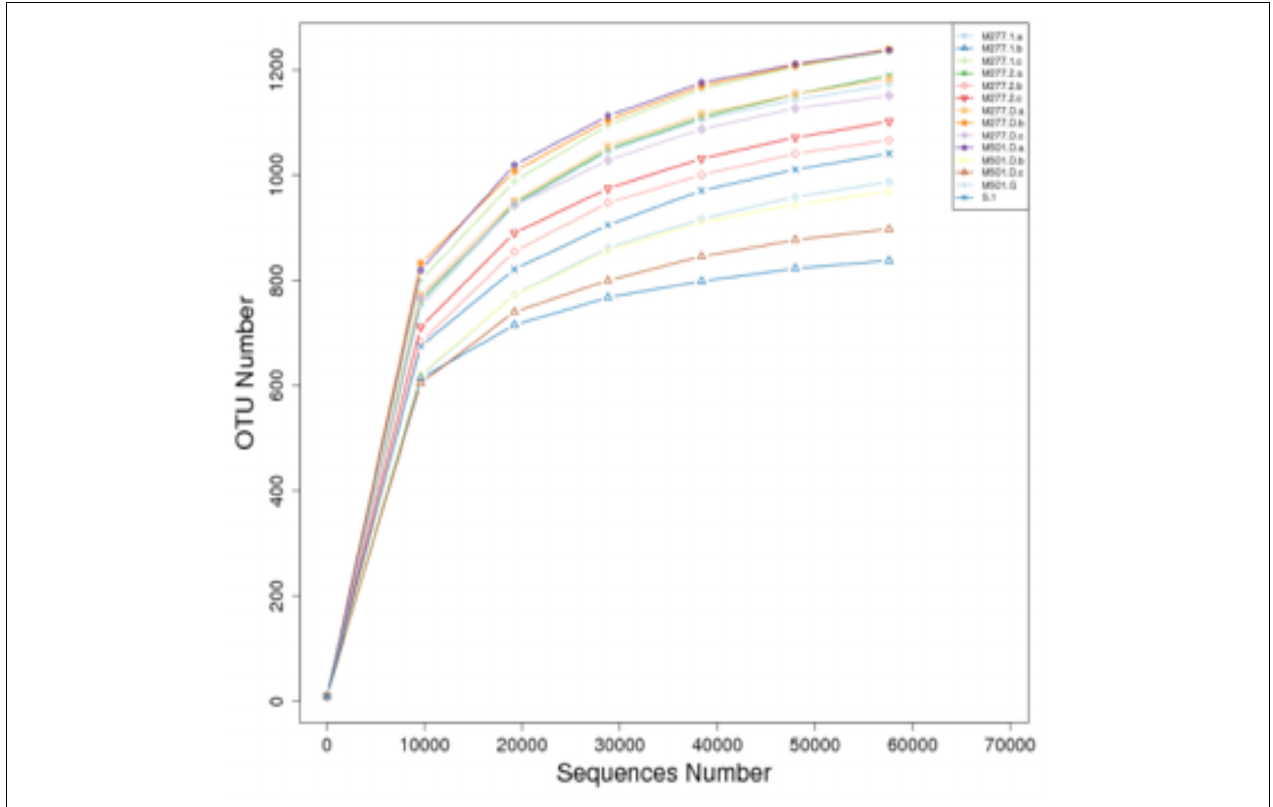
FIGURE 1 | Dilution curve of soil